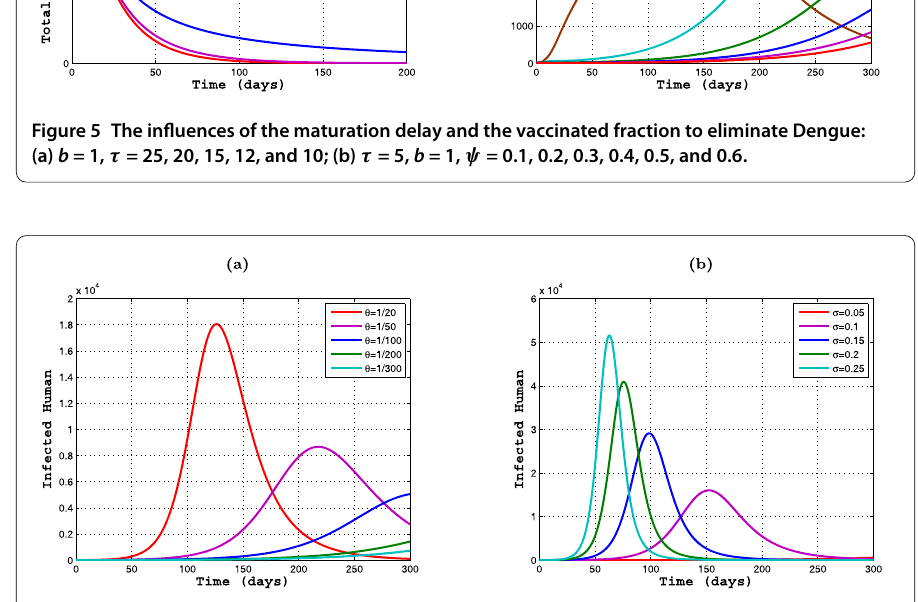
Figure 6 The influences of the waning rate θ and the infection rate of vaccinated members σ on the elimination of Dengue, where τ = 5, b = 1, and other parameters are fixed as in Table 3: (a) θ = 1/20, 1/50, 1/100, 1/200, and 1/300; (b) σ = 0.05, 0.1, 0.15, 0.2, and